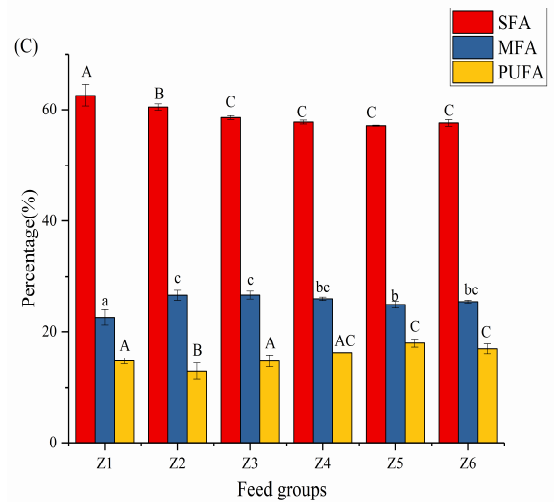
Figure 1. Nutrient composition of BSFL. ( A ) Nutrition, ( B ) amino acids, and ( C ) fatty acids. Z1, Z2, Z3, Z4, Z5, and Z6 represented the 6 experimental groups of 0, 50, 100, 200, 300, and 400 mg/L mixed flocculant, respectively. Different letters above bars indicate significant difference ( p < 0.05).